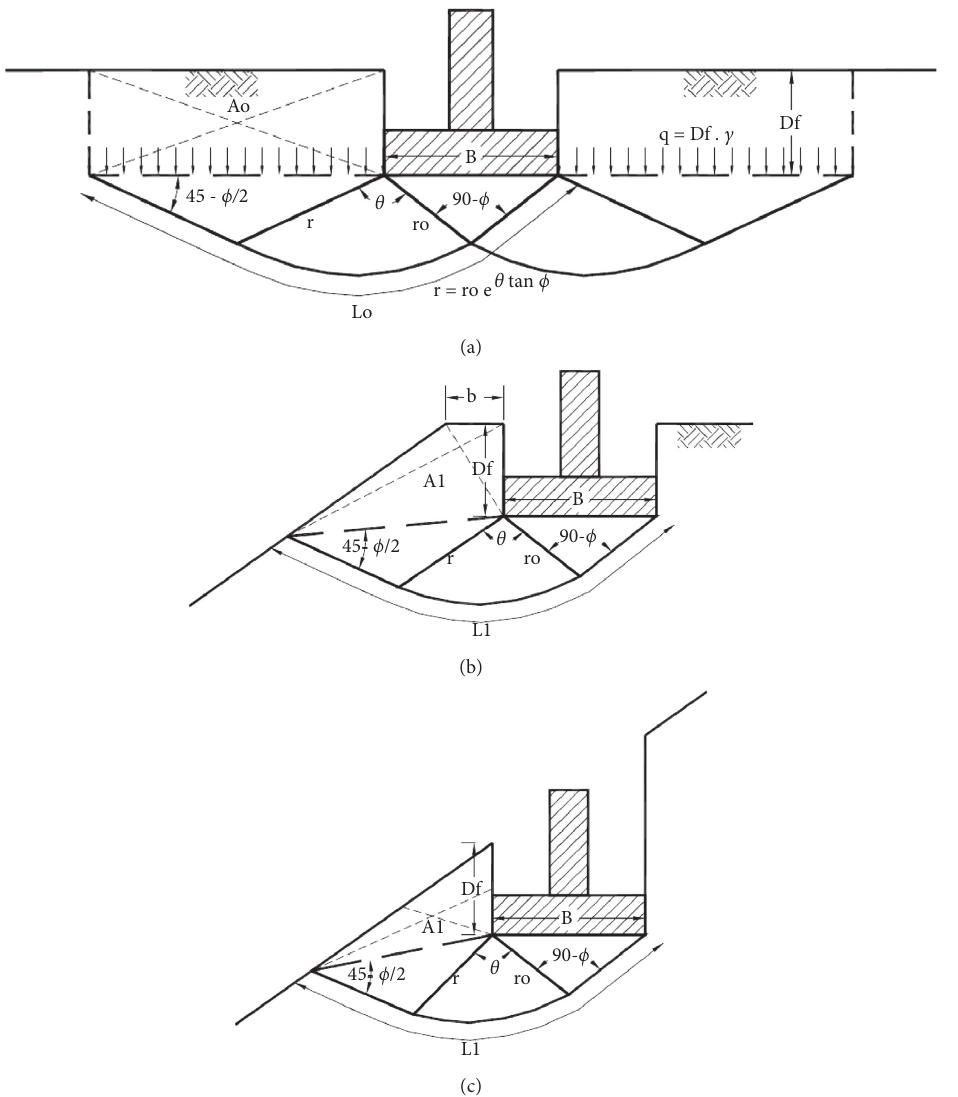
Figure 1: Shear failure mechanism for soil below strip footing after Prantdl [18]. (a) Case of strip footing with a horizontal ground surface. (b) Case of strip footing near the slope. (c) Case of strip footing within the